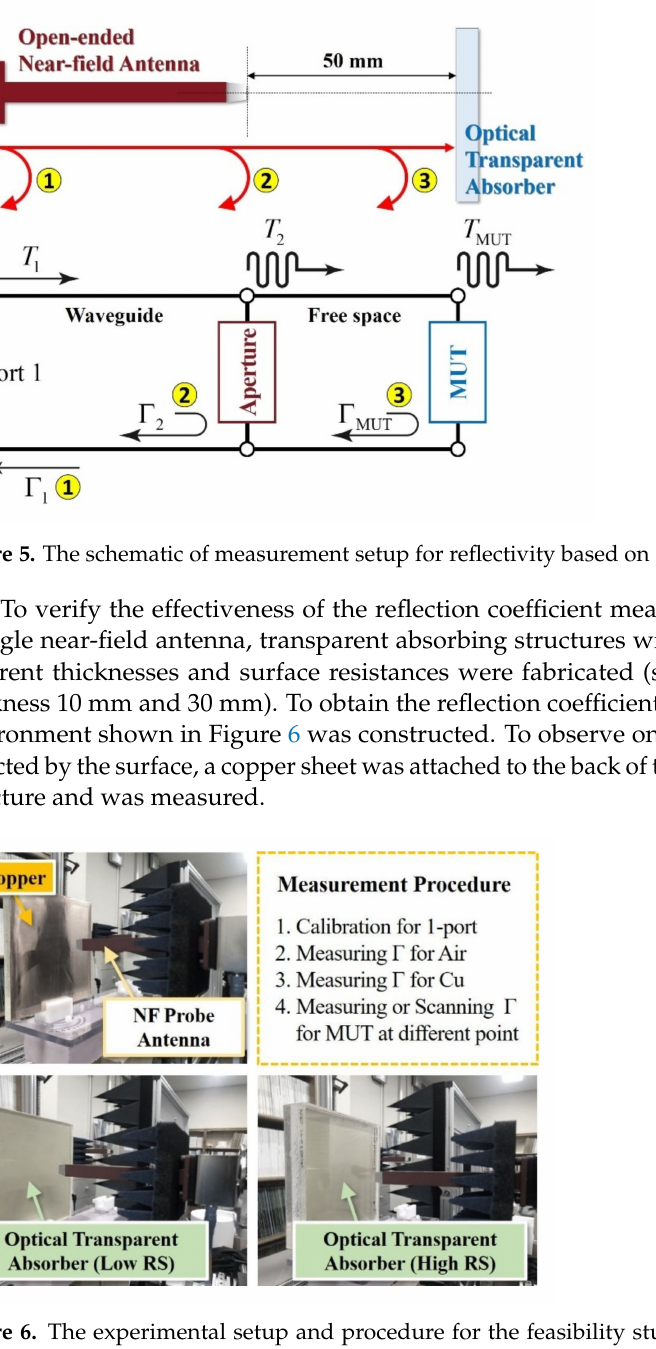
Figure 6. The experimental setup and procedure for the feasibility study of the single near-field antenna-based